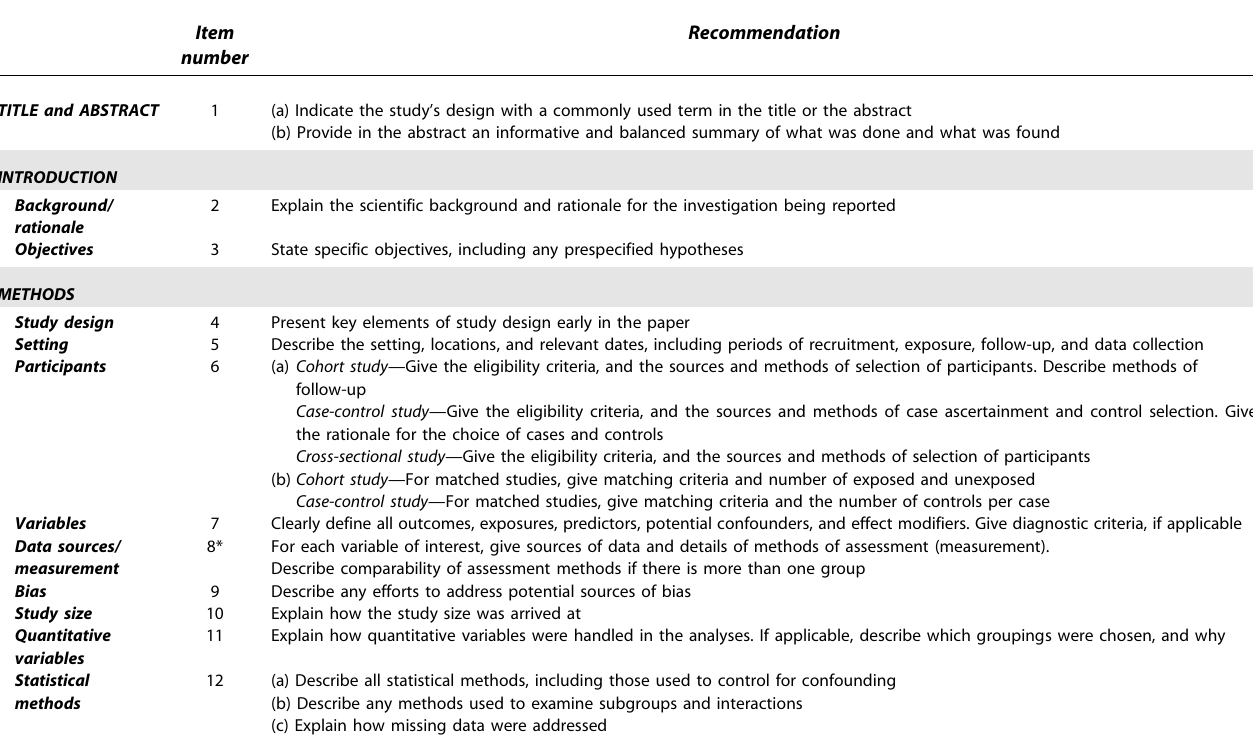
Table 1. The STROBE Statement—Checklist of Items That Should Be Addressed in Reports of Observational Studies Item